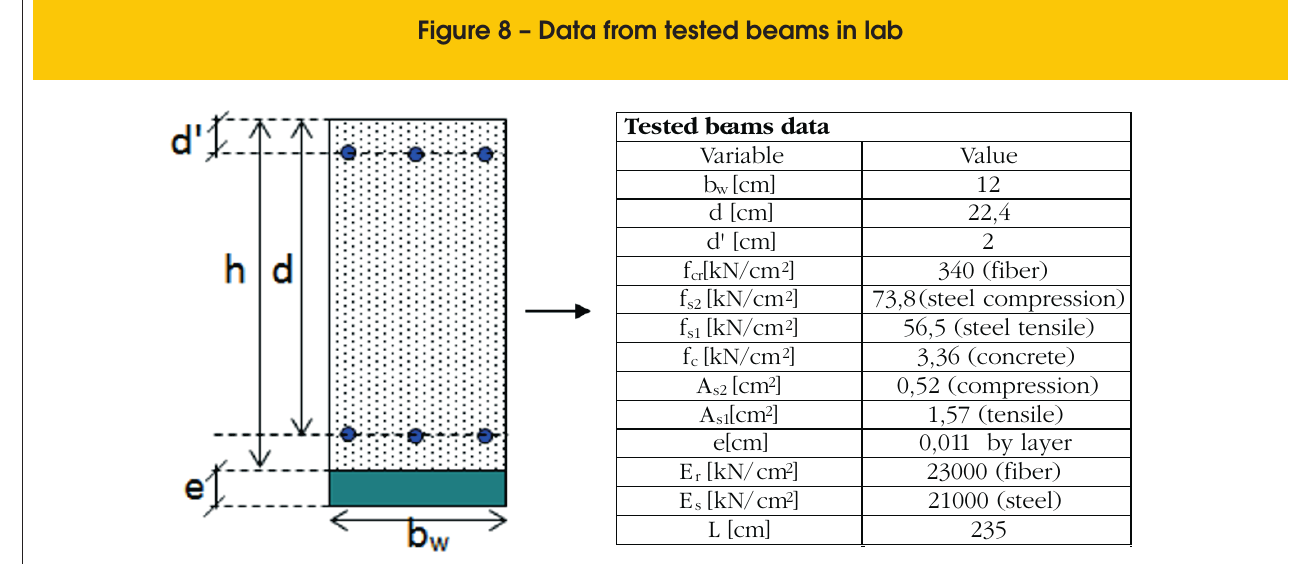
Figure 8 – Data from tested beams in lab